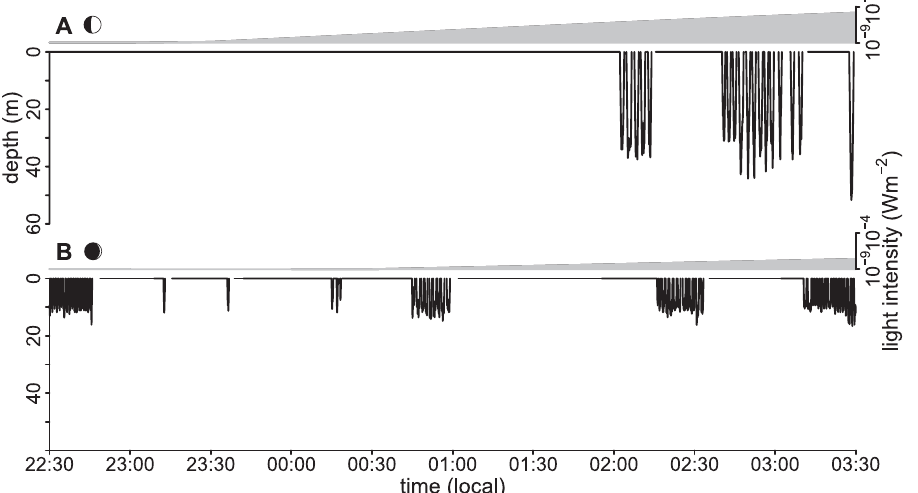
Figure 3. Changes in nocturnal diving behaviour, shown via dive profiles (black lines), in relation to modeled surface light intensity (grey area) from one murre diving during a half moon (a) and another during a crescent moon (b).